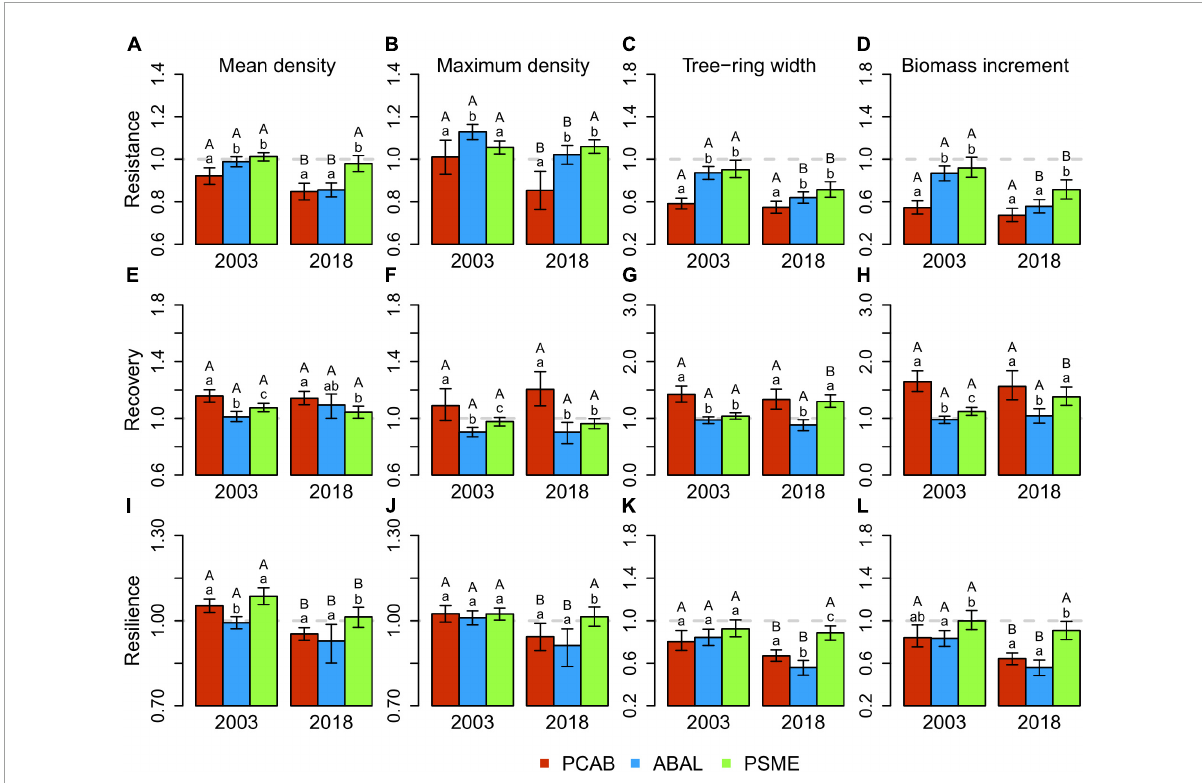
FIGURE3 Resistance (A–D) , recovery (E–H) and resilience (I–L) indices of mean tree-ring density, maximum latewood density, tree-ring width and stem radial biomass increment of Norway spruce (PCAB), silver fir (ABAL) and Douglas fir (PSME) for the two extreme drought events of the years 2003 and 2018. Error bars indicate bootstrapped 95% confidence intervals of the sample means based on 10,000 replications. Different lowercase letters above the error bars indicate significant differences between tree species within drought events. Different uppercase letters above the error bars indicate for each species significant differences between both drought events ( p <